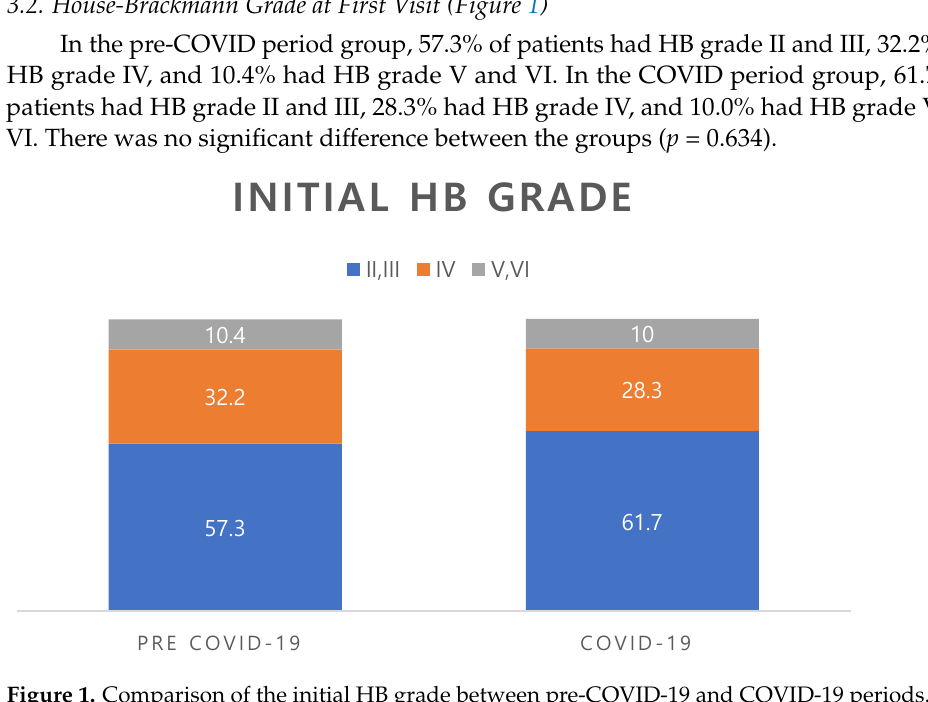
Figure 1. Comparison of the initial HB grade between pre-COVID-19 and COVID-19 periods.